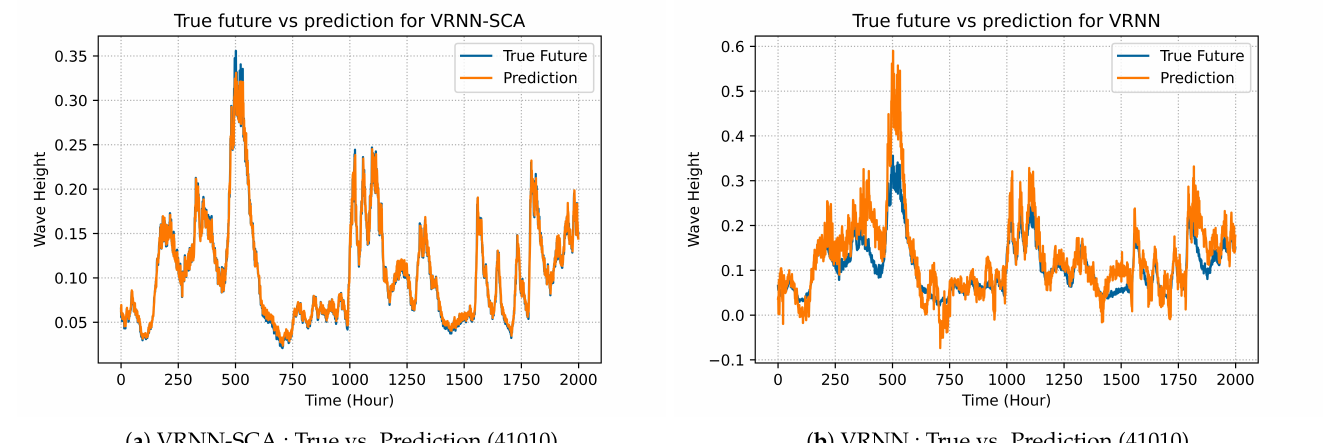
Figure 3. Comparison of VRNN models on dataset 41010.